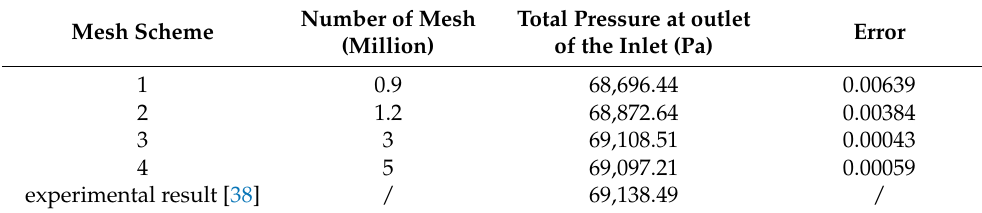
Table 1. Comparison of different mesh schemes and experimental results. Mesh Scheme